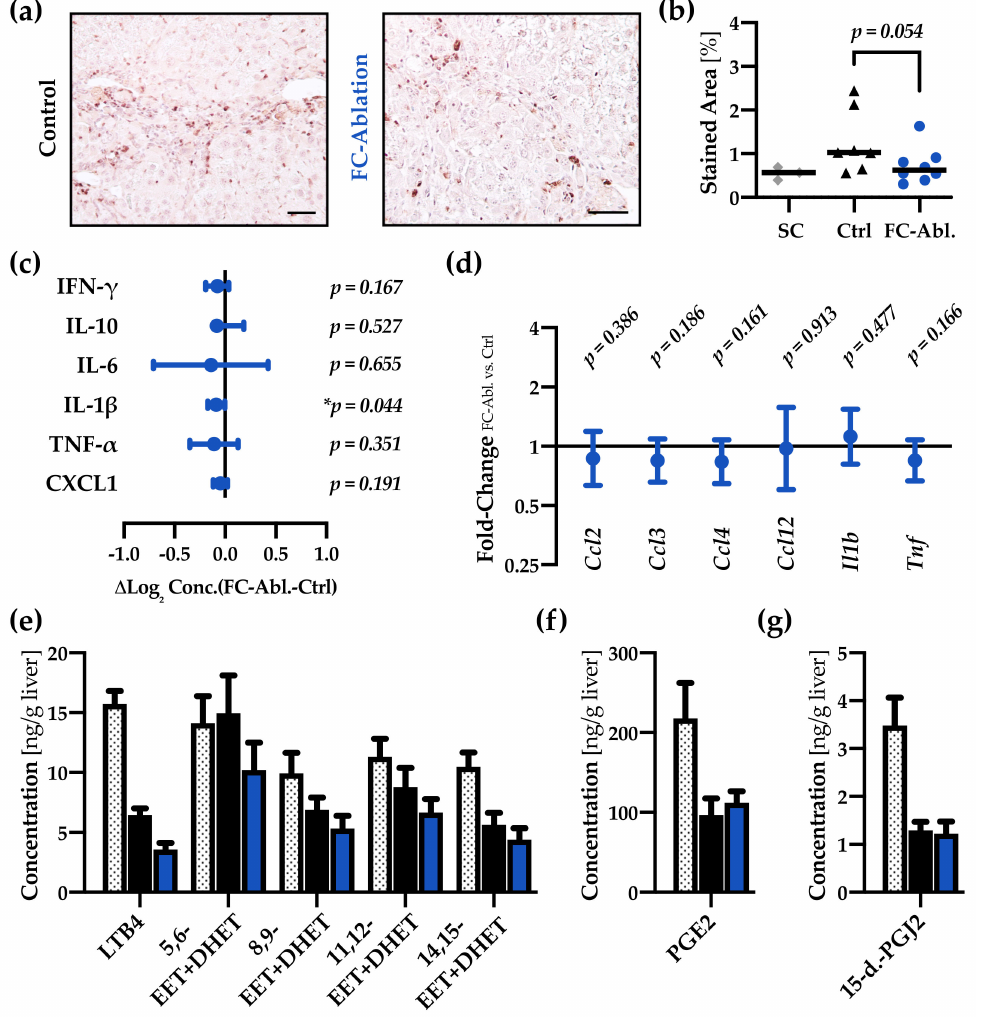
Figure4. FibrocyteablationleadtoareductionofhepaticIL-1 β levels. ( a